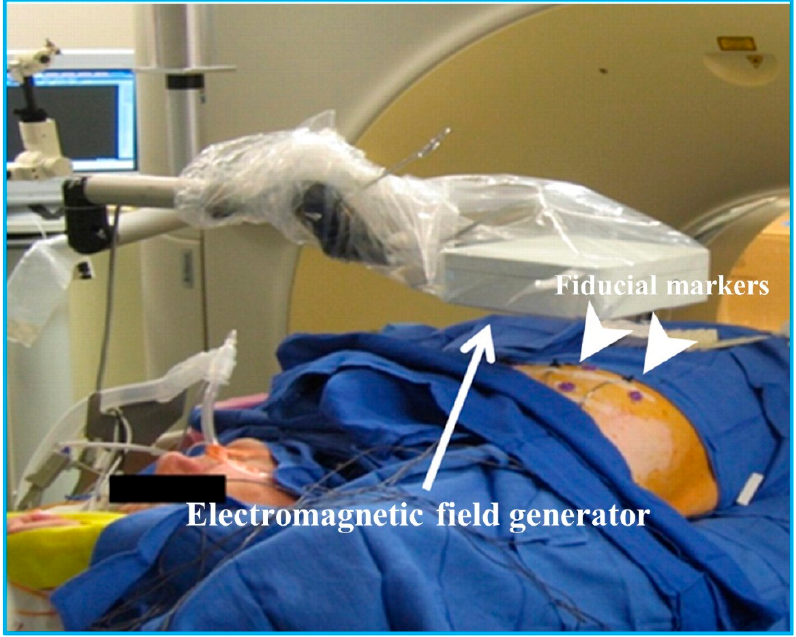
Figure 10. Equipment setup for electromagnetic tracking during interventional procedures. Reprinted from [138] with permission.